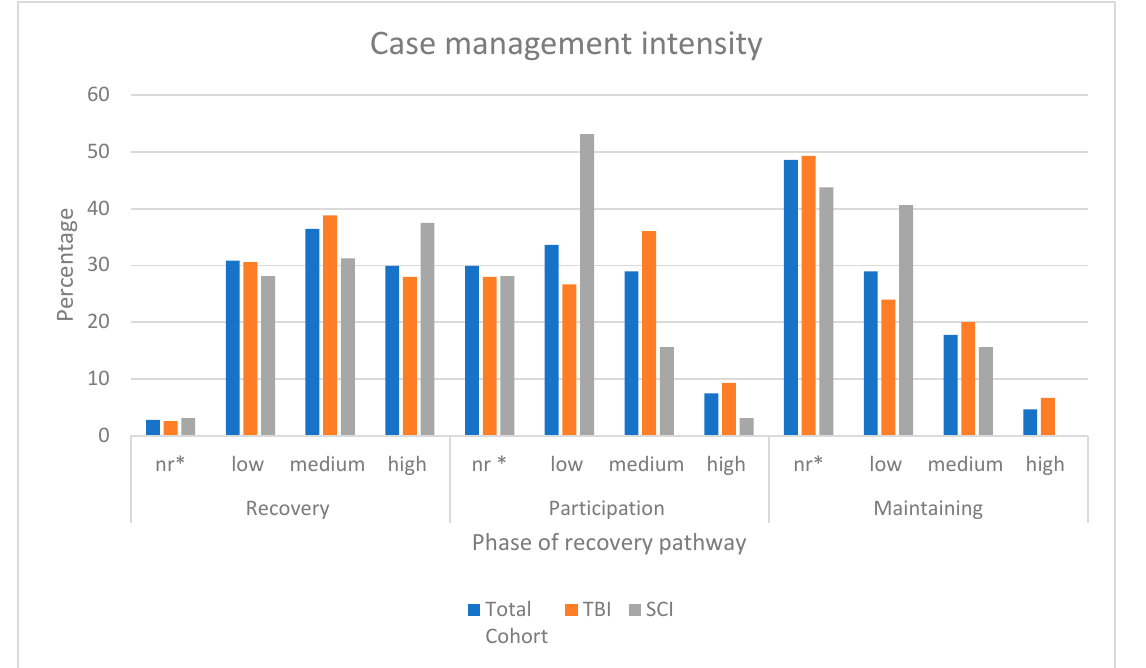
Figure 3. Case management intensity across the three phases in the recovery pathway. Key: * nr. refers to not required, not considered necessary and not performed; low intensity <3 times per month per participant; medium 1–3 times per week, per participant; high intensity (>3 times per week with the participant) [9].